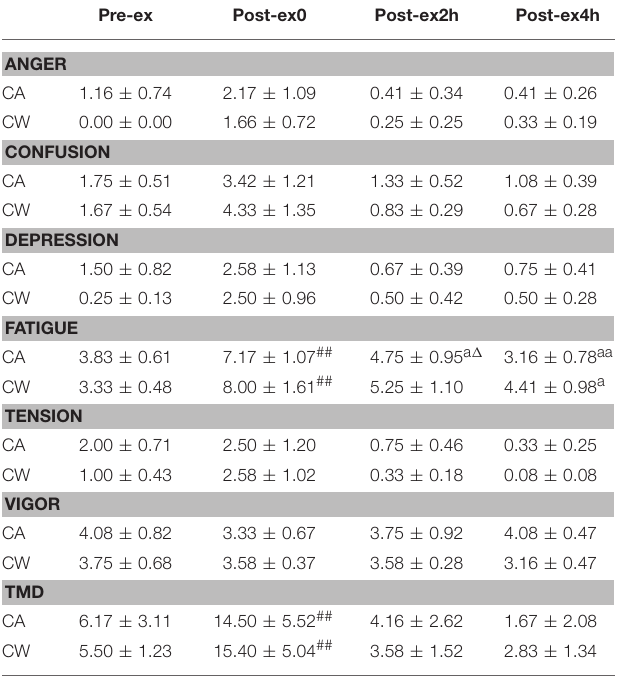
TABLE 3 | Change of mood states in both trials (M ± SE).